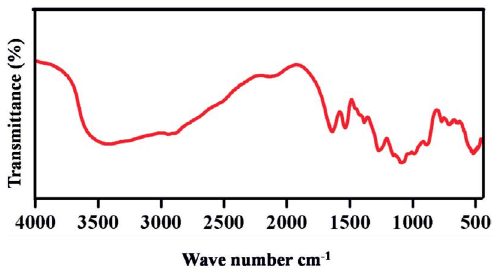
Fig.2. FTIR spectrum of Chitosan